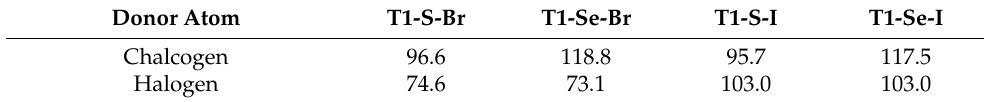
bond with the π -electron cloud, S1···C5, at 3.497 Å and 161.20° (Figure 4).